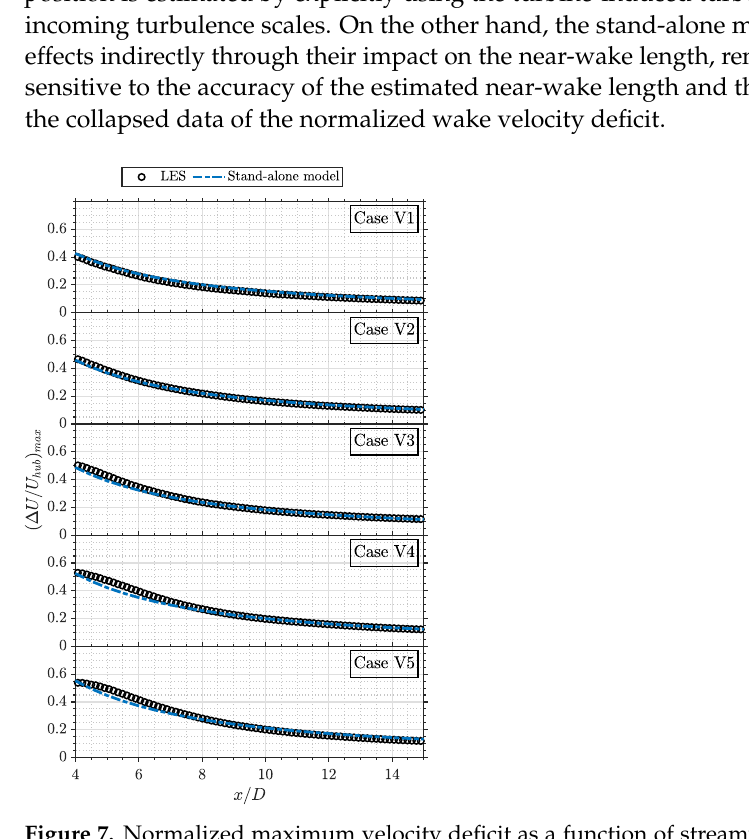
Figure 7. Normalized maximum velocity deficit as a function of streamwise distance. The circles indicate LES results and the dash-dotted line corresponds to the stand-alone